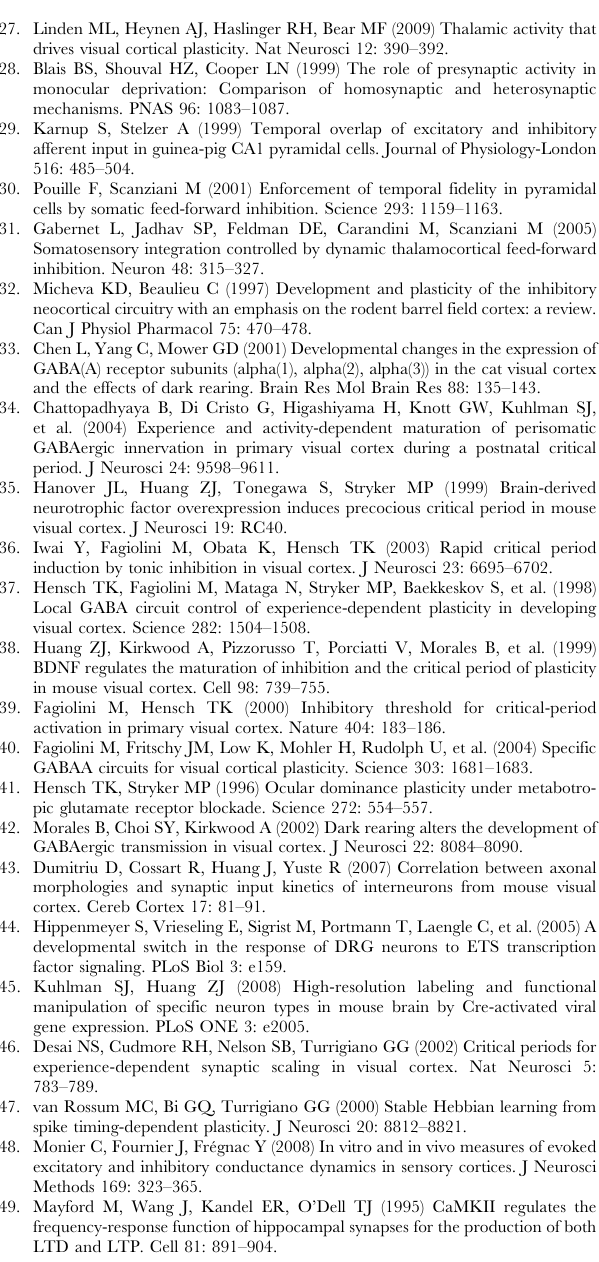
Figure S5 Short-term dynamics of unitary IPSCs at mature Pv + interneuron to pyramidal synapses. As expected from previous reports [78], IPSCs were depressing in response to 20 Hz stimulation, and depression was less pronounced at higher stimulation frequencies [79]. The average paired pulse ratio (IPSC amplitude 2 /IPSC amplitude 1 ) during the critical period (age p21-27) at 20 Hz stimulation was 0.71 + / 2 0.05 (n= 6), and at 100 Hz stimulation was 0.89 + / 2 0.11 (n= 7). Left, example cell pair at 20 Hz stimulation, average of 15 traces. Right, example cell pair at 100 Hz stimulation, average of 5